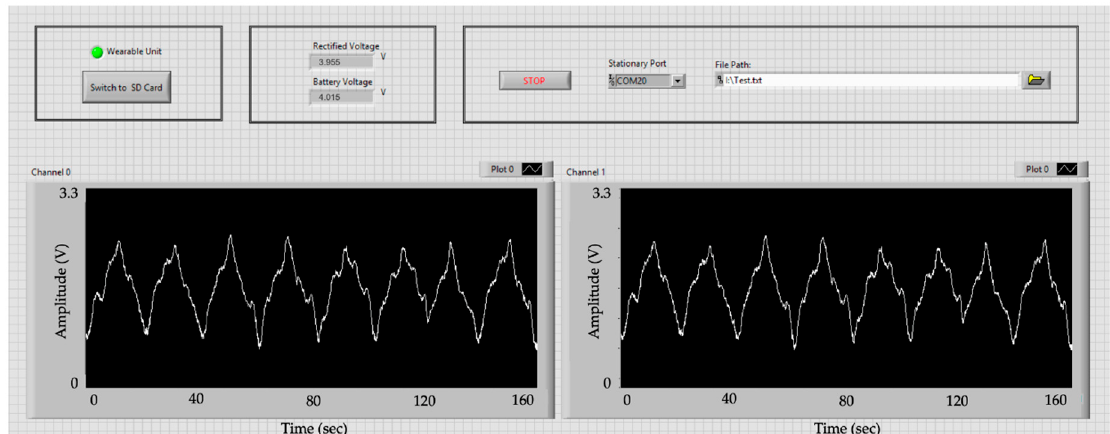
Figure 11. Signals received in the GUI is shown. X and Y axes are time (0 to 160 s) and amplitude (0 V to 3.3 V), respectively. Only two of 64 channels are shown, here. Eight slow-wave peaks in a time window of 160 s translates to 3 cycles per minute.